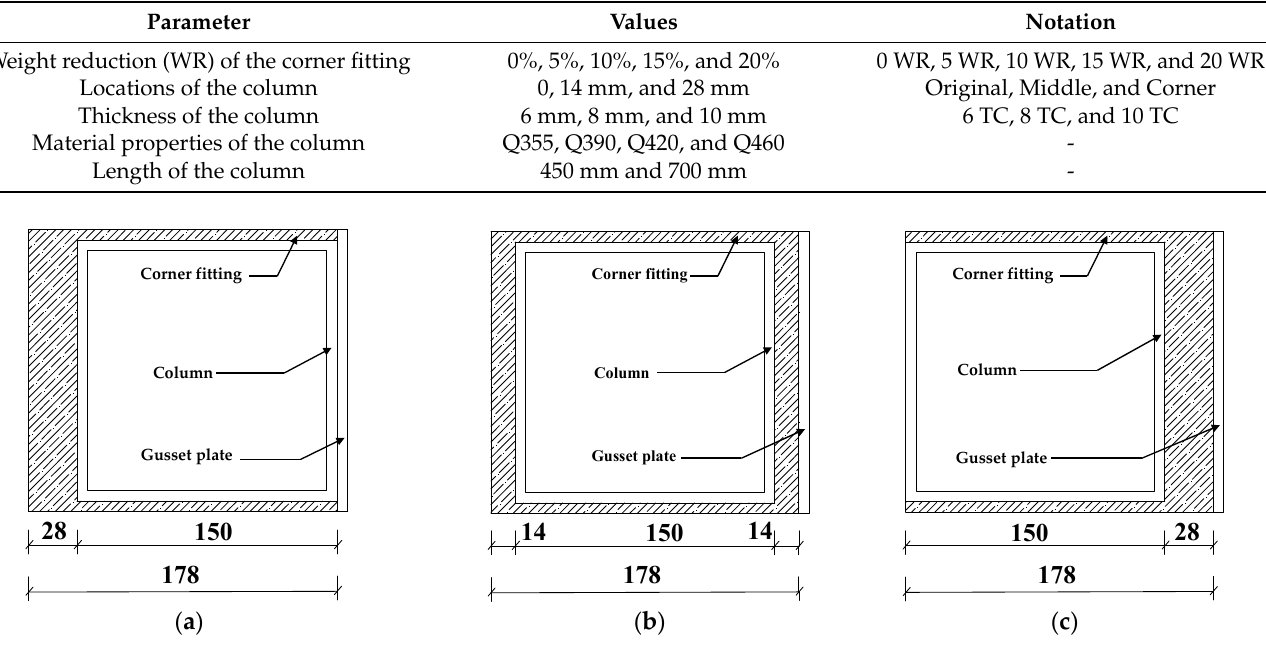
Figure 18. Locations of columns on the corner fitting: ( a ) original location; ( b ) middle location; and ( c ) corner location.